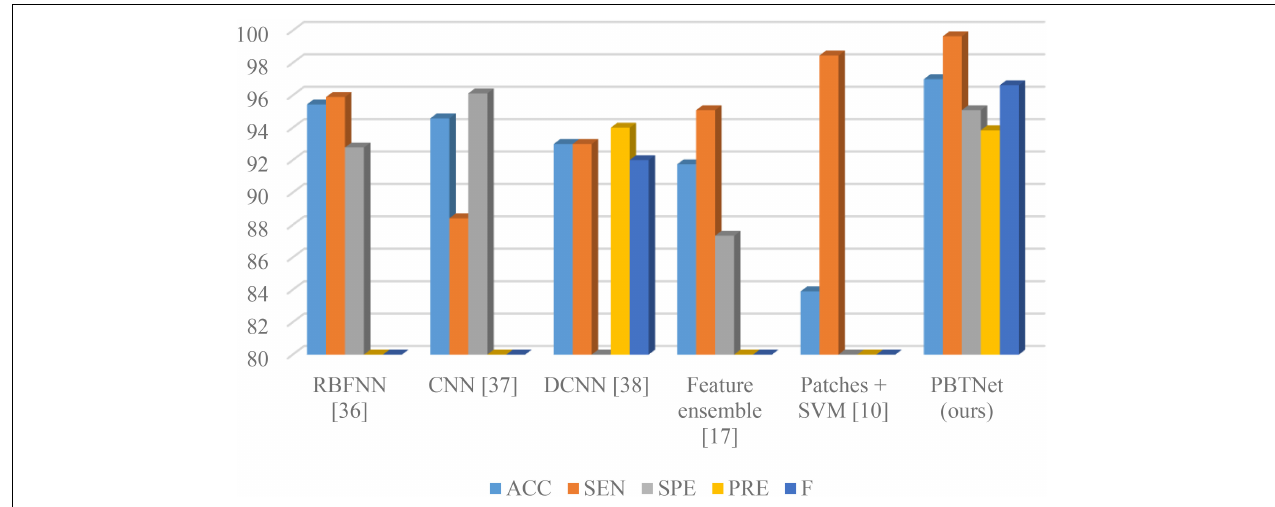
FIGURE 9 | Comparison with state-of-the-art methods (unit: %).